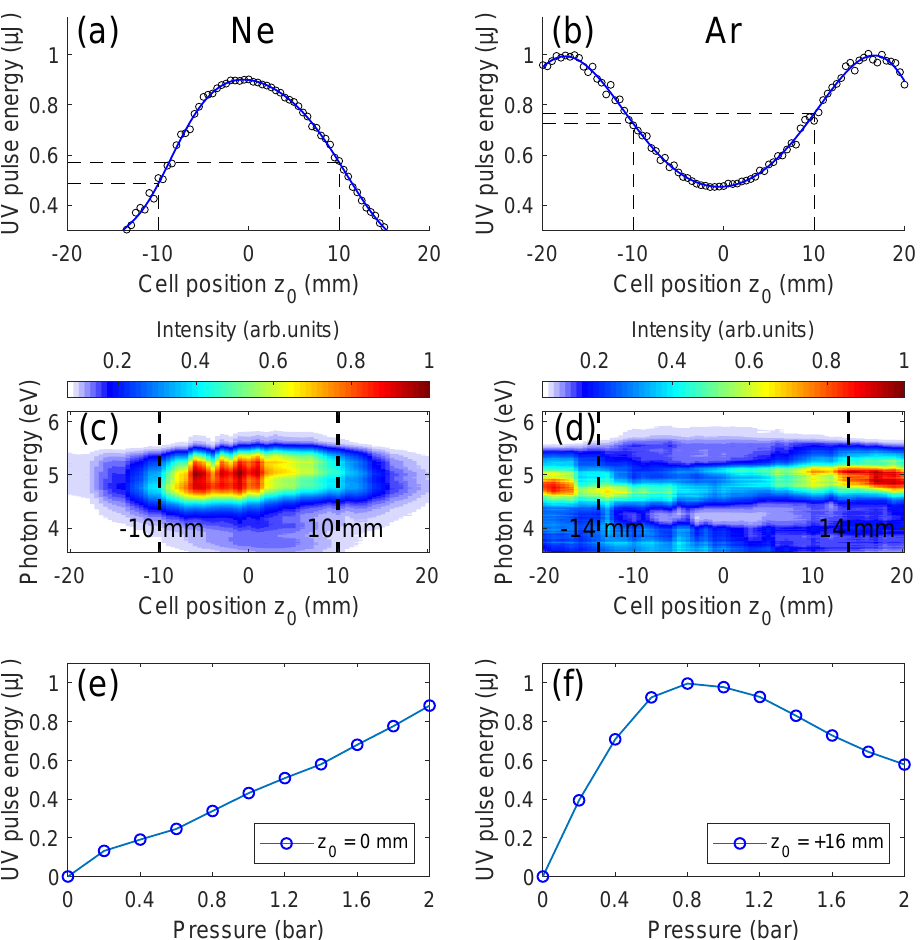
Figure 3. DUV pulse energies and spectra are plotted by the cell position when 2 bar Ne ( a , c ), and 0.8 bar Ar ( b , d ) targets are used. ( e , f ) show the DUV pulse energies at fixed cell positions, measured by changing the gas pressure: ( e ) Ne and ( f )